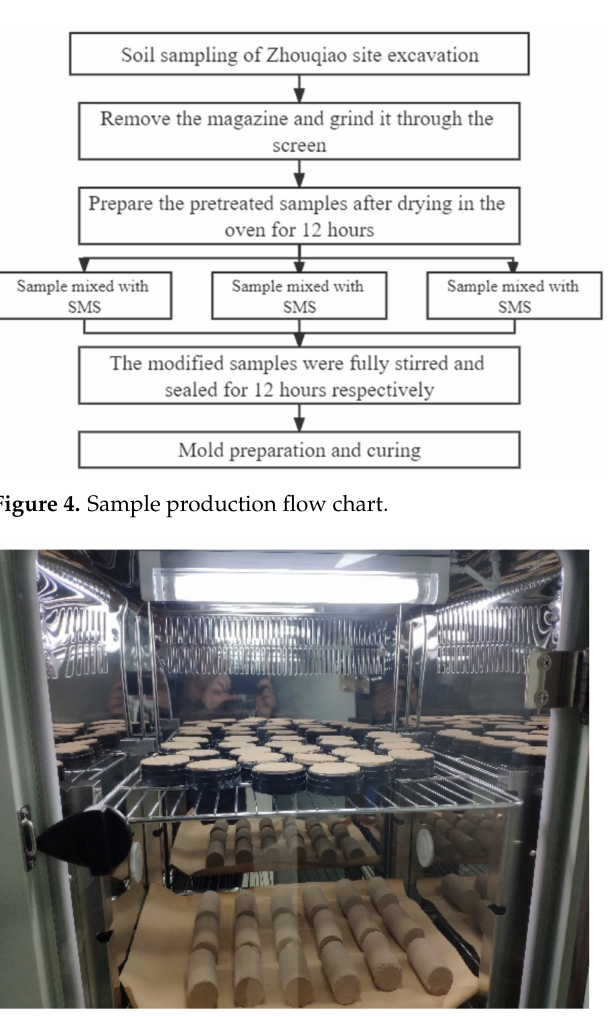
Figure 5. The finished